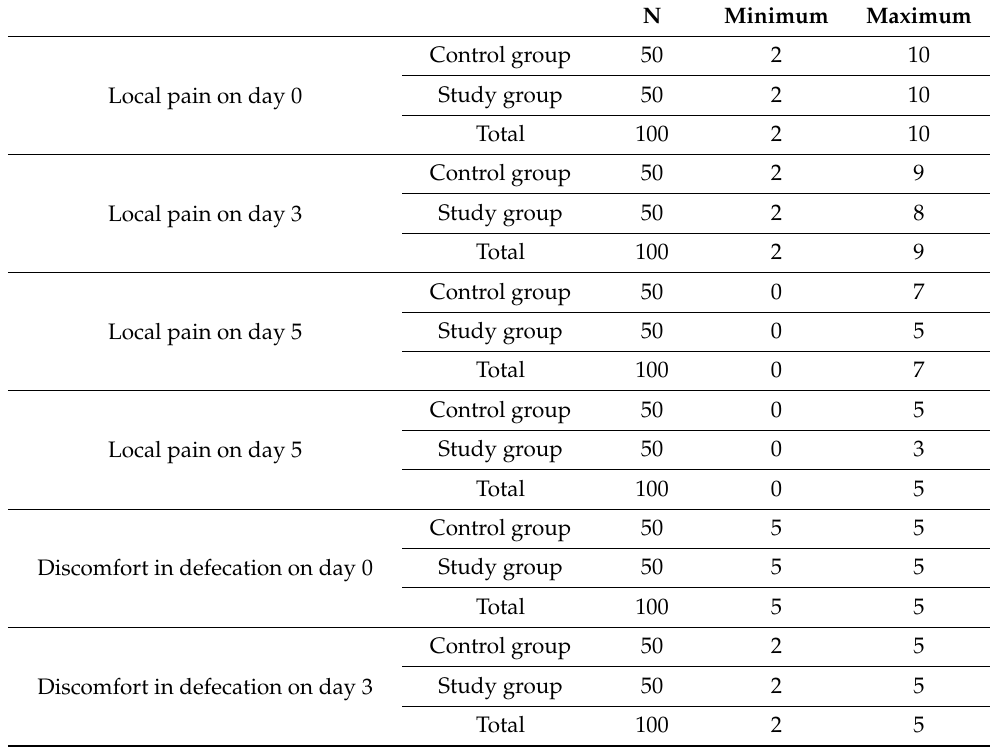
Table 4. Descriptive statistics on the control and study